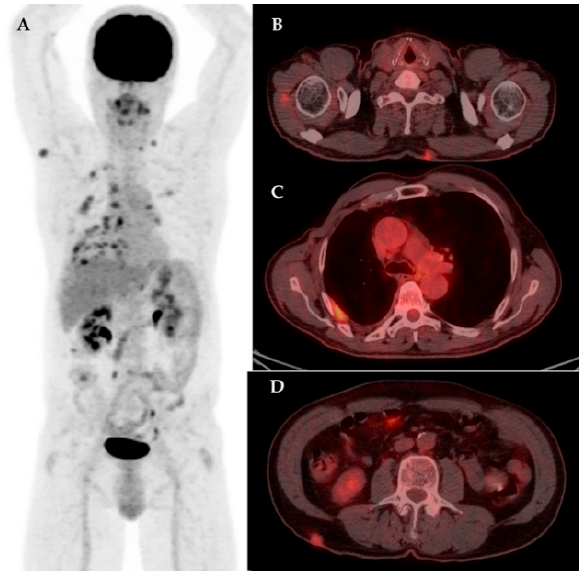
Figure 1. Male patient with right breast cancer, with right radical mastectomy and axillary lymphnode dissection, with multiple sites of increased F18-FDG uptake confirmed as breast carcinoma metastases. MIP image on F18-FDG PET/CT ( A ); axial section at cervical level showing muscle and posterior cervical subcutaneous lesions with increased F18-FDG uptake confirmed metastases on biopsy ( B ); axial section at thorax level showing pathologic increased F18-FDG uptake in the right pleura ( C ); axial section at lumbar level showing right posterior lumbar subcutaneous lesion with increased F18-FDG uptake confirmed metastases on biopsy ( D ).